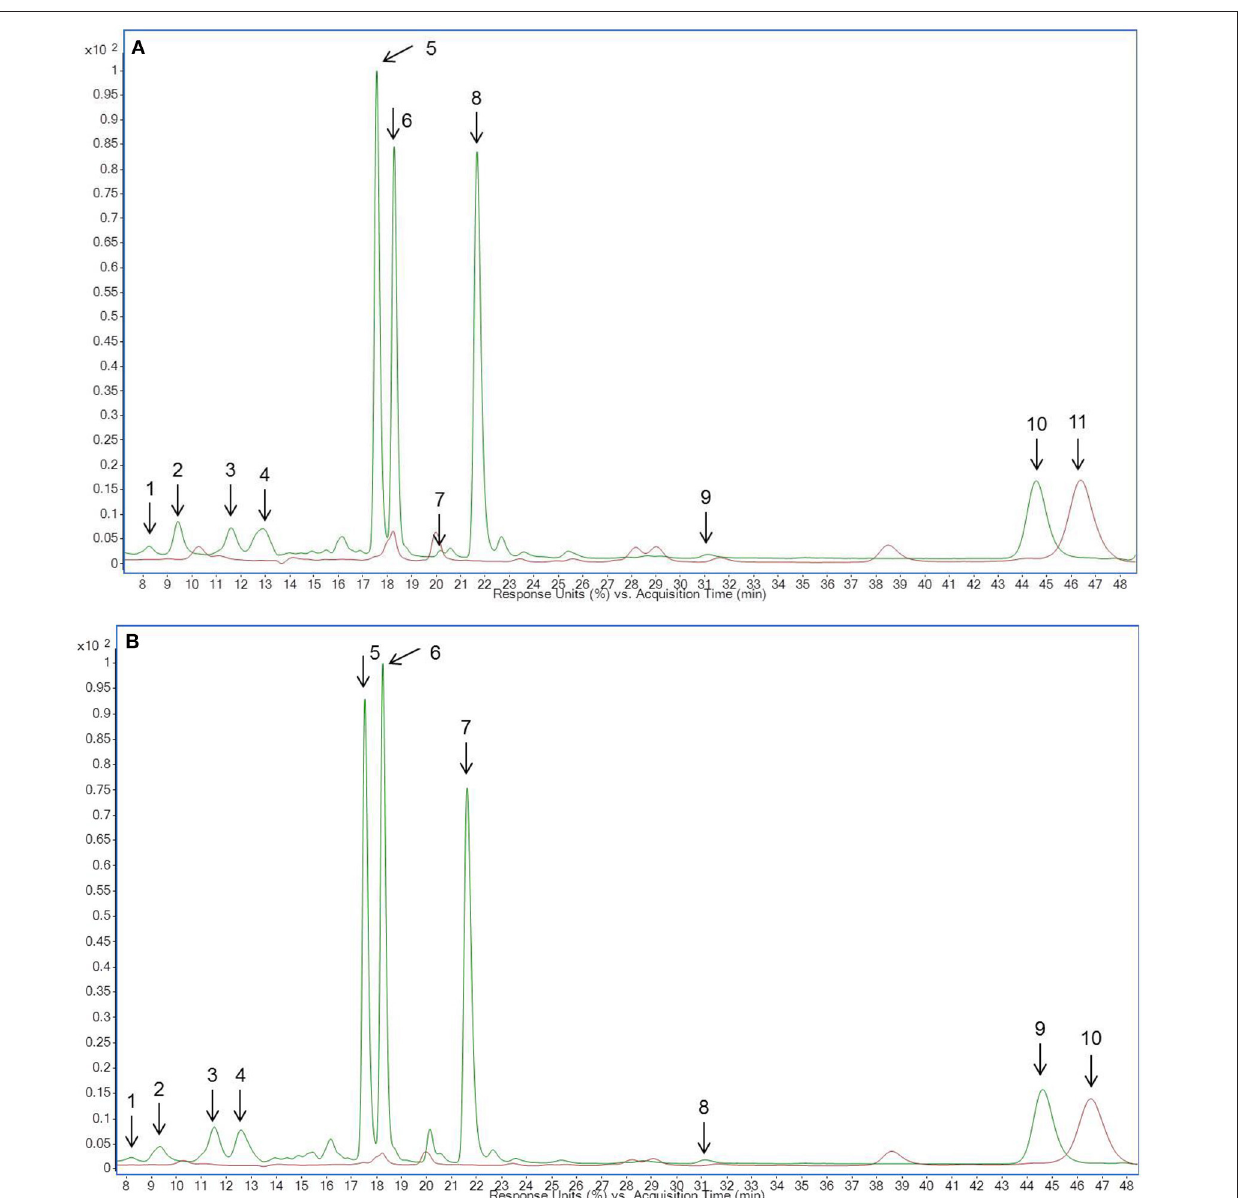
FIGURE 5 | HPLC chromatogram of carotenoid and chlorophyll metabolites in (A) lupin microgreens (green) vs. lupin microgreen bread (brown) and (B) lupin leaves (green) vs. lupin leaf bread (brown). Intensity in mAU, extract at 440nm. The bread contains 10.7% plant material, hence a dilution factor of 10.7% has to be taken